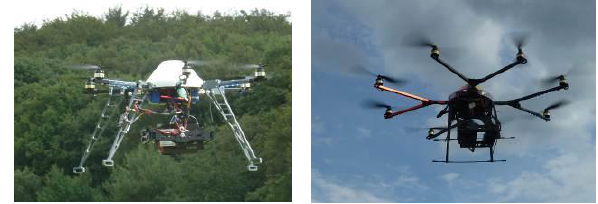
Figure 1. Hexa- and Oktokopter during flight